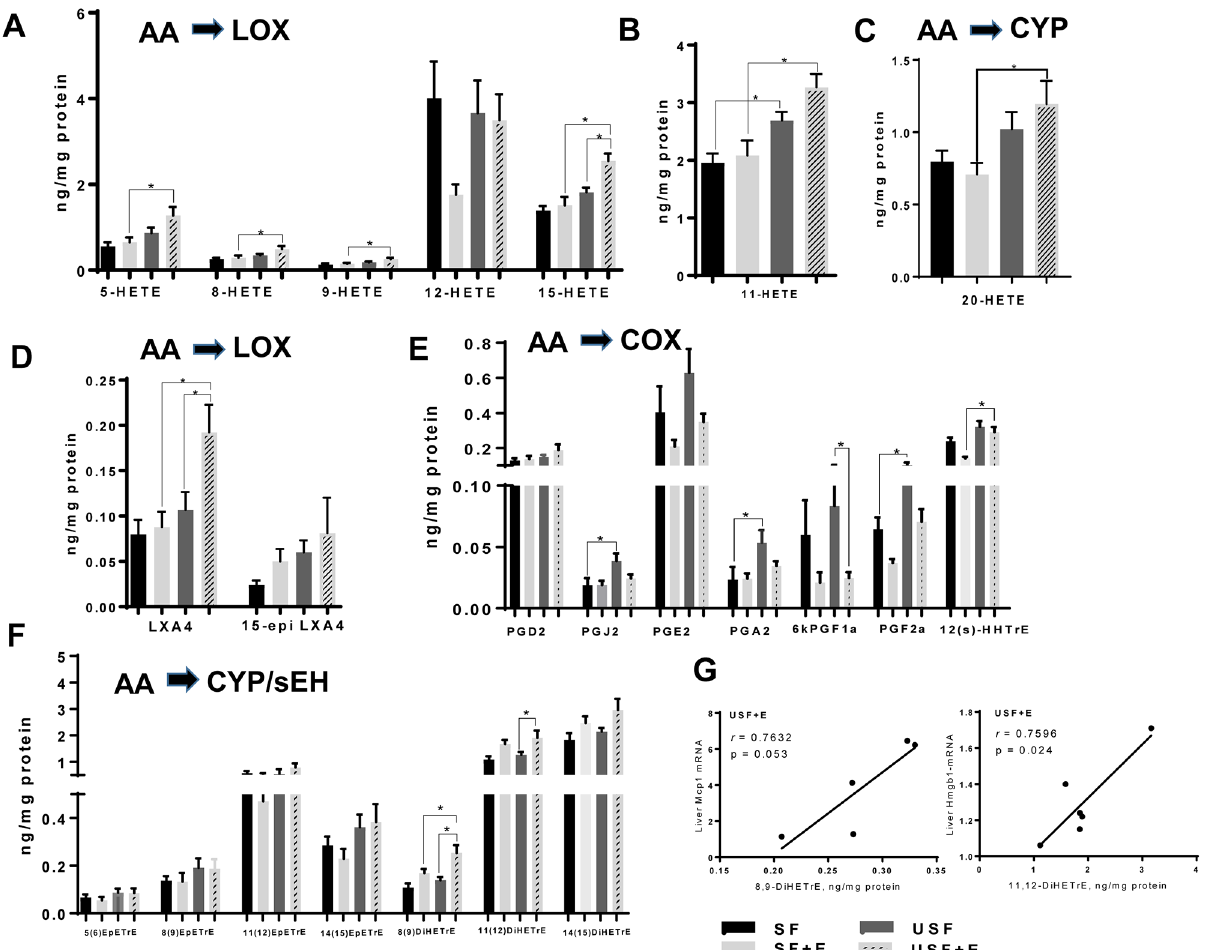
Fig 6. Changes in hepatic oxylipins derived from arachidonic acid. A: Changes in the profile of LOX-dependent hydroxy-metabolites of AA. B: Levels of 11-HETE. C: Levels of 20-HETE (COX pathway). D: Levels of lipoxins (LOX pathway). E: Levels of AA-derived prostaglandins (COX pathway). F: Changes in epoxy- and dihydroxy-metabolites of AA derived via CYP/sEH pathway. G: Pearson correlation analysis between AA metabolites and markers of hepatic inflammation and injury: 8,9-DiHETrE and Mcp1 mRNA, and 11,12-DiHETrE and Hmgb1 mRNA. Data are presented as the mean ± SEM, Two way ANOVA, (cid:3) P < 0.05, n = 6 animals per group. AA, arachidonic acid; CYP, cytochrome-P450 epoxygenase; E, ethanol; LOX, lipoxygenase; SF, saturated fat; sEH, soluble epoxide hydrolase; USF, unsaturated fat. See oxylipin abbreviations in S2